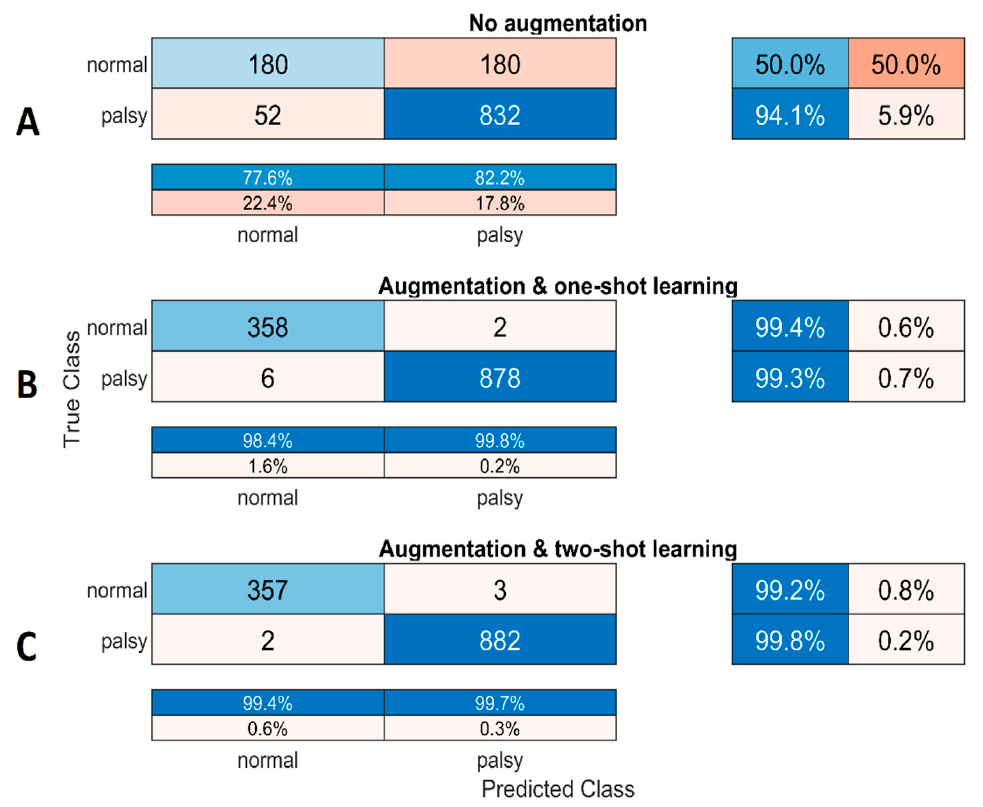
Figure 8. Confusion matrix showing the performance of our model on ( A ) original dataset, ( B ) using augmentation and one-shot learning, and ( C ) using augmentation and two-shot learning. The best performance was obtained using two-shot learning with the proposed VDRRE method using the hybrid SqueezeNet/ECOC-SVM classifier, achieving 99.34% accuracy, 99.74% recall, 99.35% precision, and 99.54% F1-score. The results for the corresponding case with one-shot learning were only slightly worse, achieving 99.07% accuracy, 99.72% recall, 98.85% precision, and 99.28% F1-score. However, both one-shot and two-shot learning with VDRRE augmentation achieved much better results than the baseline (classification on original dataset images without any data augmentation), which achieved only 78.62% accuracy, 91.85% recall, 81.06% precision, and 85.59% F1-score. To effectively visualize the ability of the SqueezeNet network to extract efficient features, we used the t-distributed stochastic neighbor embedding (t-SNE), which uses principal component analysis (PCA) for feature dimension reduction. t-SNE [59] is a dimensional data into a 2D map as shown in Figure 9. The results depicted in Figure 9 clearly show that the 2D embeddings of palsy face images make a cluster, which is